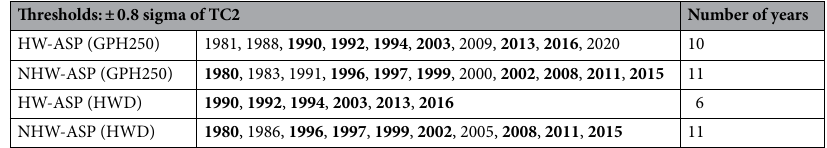
Table 2. Heatwave and non-heatwave years originating from the ASP (HW-ASP and NHW-ASP) were defined by the ± 0.8 standard deviation thresholds of the 2nd SVD mode time coefficients (TC2) for GPH250 and HWD. Underlined years indicate those in phase with the HWY from detrended HWD. Bolded years mean those in step with the HW-ASP (GPH250) and HW-ASP (HWD).